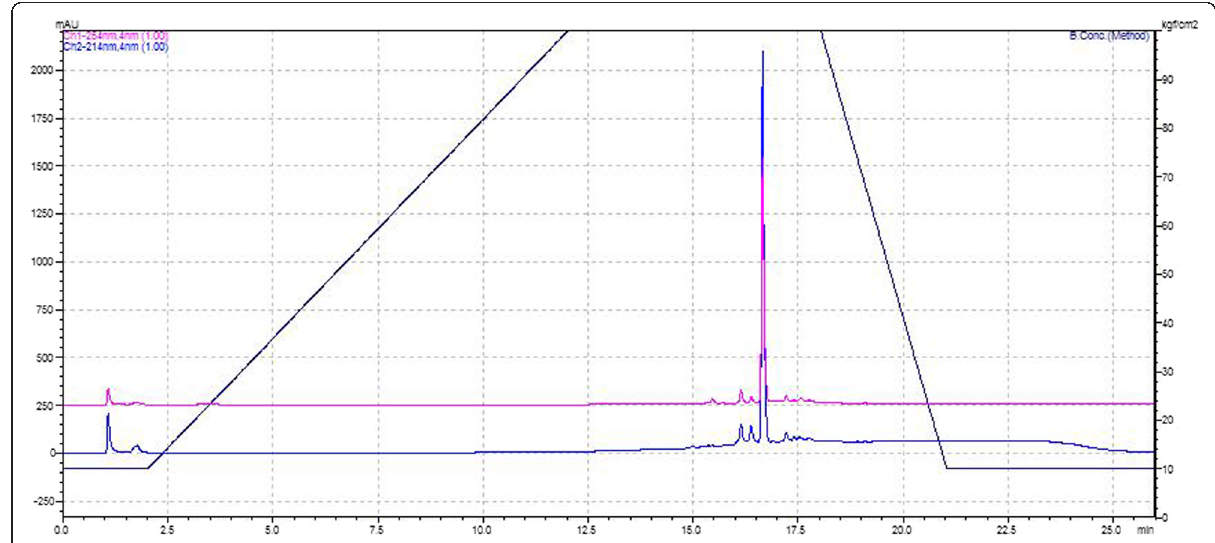
Figure 1 Chromatographic profile of hexane and ethyl acetate unified fractions obtained by RP-UPLC-PDA in a C18 column (ACE C18, 5 μ m, 100 Å, 250 mm×4.6 mm) at a constant flow rate of 1 mL/min − 1 using water as solvent A and MeOH as solvent B. The chromatogram was obtained at wavelengths of 214 and 254 nm.